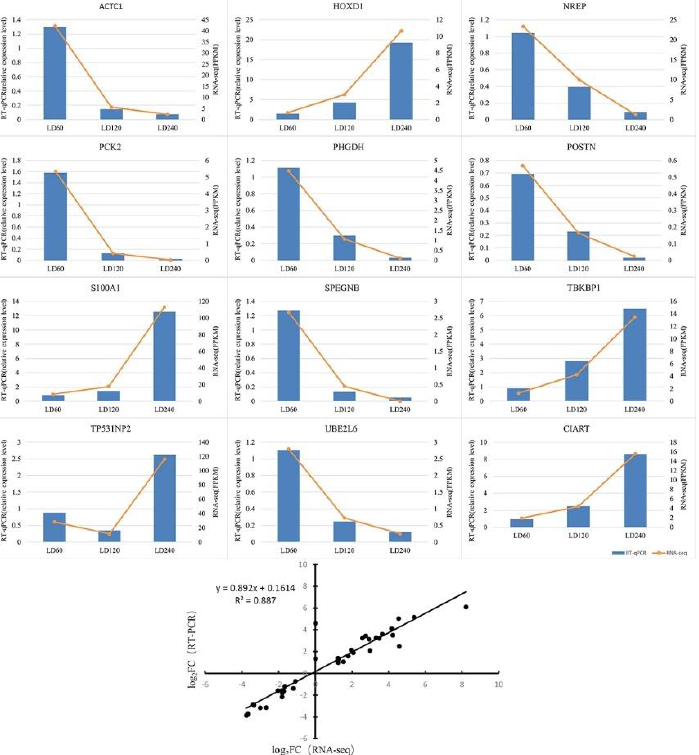
Figure 8. Experimental verification of gene expression level across three time points using RT-qPCR ( n = 3). Note: The Y -axis on the left side of the histogram represents the gene expression level accord- ing to RT-qPCR, and the right Y -axis represents the standard value of FPKM based on tran- scription.